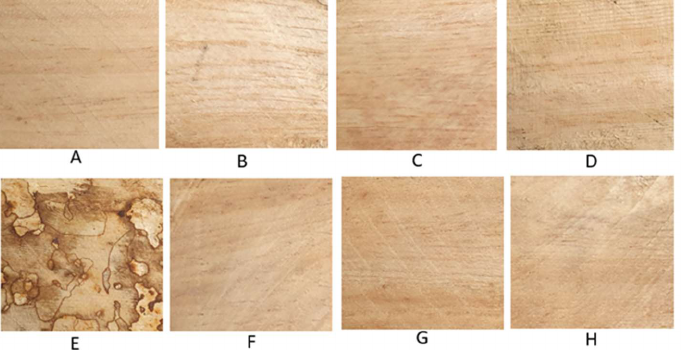
Figure 1. Appearances of cleaned and oven dried wood blocks subjected to various treatments (at the completion of the experiment), ( A ) Control (C); ( B ) Trichoderma consortium (T); ( C ) streptomy- cetes consortium (S); ( D ) Trichoderma and streptomycetes consortium (TS); ( E ) P. noxium (P); ( F ) Trichoderma consortium and P. noxium (TP); ( G ) streptomycetes consortium and P. noxium (SP); ( H ) P. noxium with all the BCAs